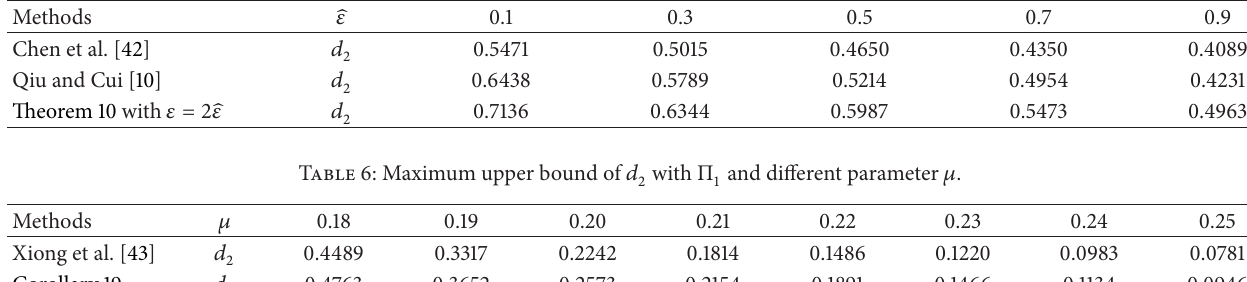
Table 5: Maximum upper bound of 𝑑 2 with different 𝜀 and parameter 𝜇 = 0.9 .